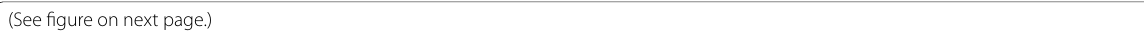
figure on next Fig. 6 Effect of an miR‑1279 mimic on circ_0007059‑induced cell viability, apoptosis, and IFN‑associated inflammation of RMCs and HEK293 cells. RMC and HEK293 cells were cotransfected with a circ_0007059‑overexpressing vector and/or NC/miR‑1278 mimic for 24 h, followed by treatment with 1000 units/mL IFN for 24 h. Expression of A , B miR‑1278 or C , D SHP‑1 was evaluated by RT‑qPCR in cells with different transfected constructs (biological replicates, 1; technical replicates, 3; repeat time, 3). E , F WB was performed to detect SHP‑1, STAT3, and phosphorylated STAT3 levels in RMCs and HEK293 cells (biological replicates, 1; technical replicates, 3; repeat time, 3). G , H cell viability of RMCs and HEK293 cells was examined using the MTT assay (biological replicates, 1; technical replicates, 3; repeat time, 3). I , J the number of apoptotic cells was assessed by flow cytometry (biological replicates, 1; technical replicates, 3; repeat time, 3). K , L expression of CXCL10, IFIT1, ISG15, and MX1 mRNA in RMCs and HEK293 cells was determined by RT‑qPCR (biological replicates, 1; technical replicates, 3; repeat time, 3). Results are expressed as the mean replicates. *P < 0.05, **P < 0.01 vs. the indicated